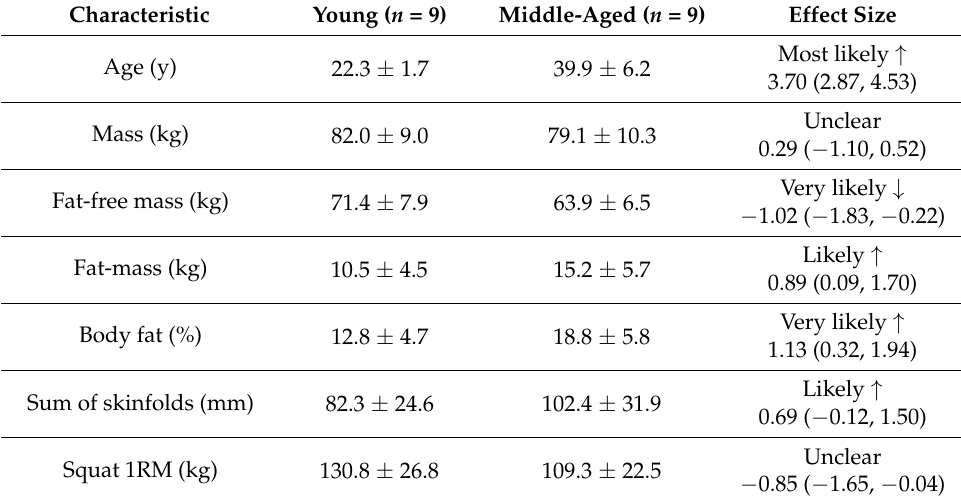
Table 1. Biometric characteristics (mean ± SD) of the young and middle-aged groups. Qualitative descriptor, effect size, and upper and lower 90% confidence intervals are noted in the effect size